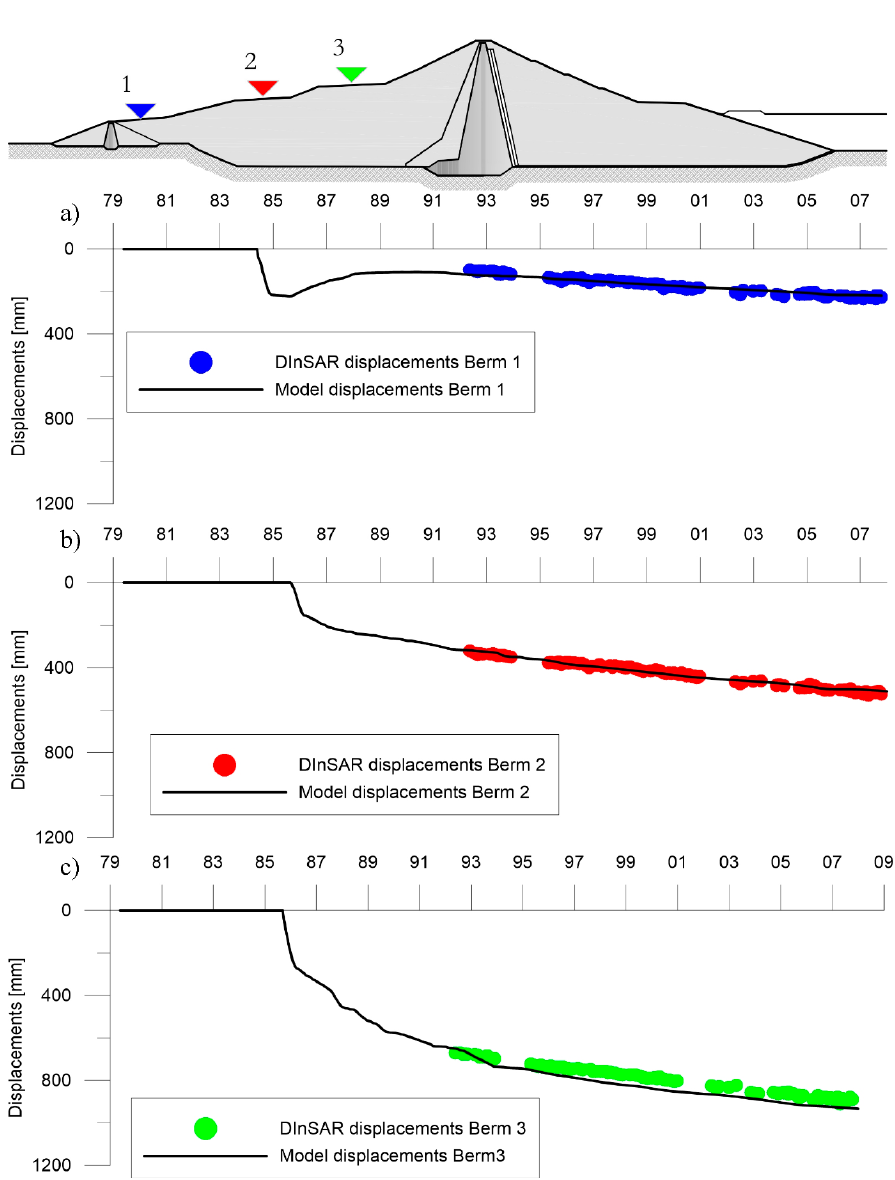
Figure 27. Comparison between DInSAR observed displacement and model obtained displacement for: ( a ) berm 1; ( b ) berm 2 and ( c ) berm 3.